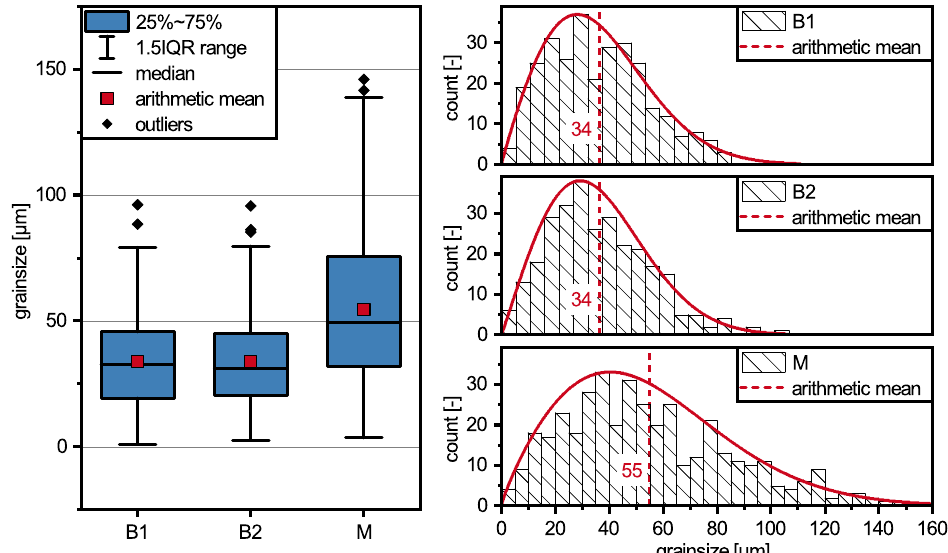
Figure 7. Visualization of the grain size distribution of the investigated materials determined by line intercept method. The box diagram on the left displays the medians and arithmetic means, interquartile ranges (IQR), and outliers of the dataset. Additionally, the grain size histogram is displayed on the right together with the corresponding Weibull fit and the arithmetic mean, which is represented by the dashed